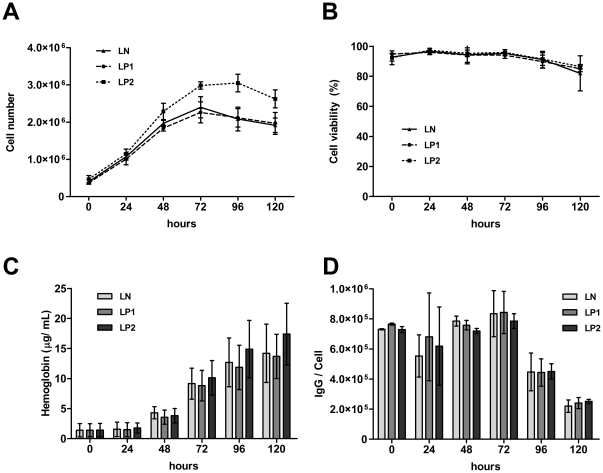
Differentiating MEL cells display similar characteristics irrespective to the level of PrPC expression.(A) Growth curves of LP1, LP2 and control LN lines during erythroid differentiation induced by HMBA. (B) Cell viability based on a Trypan Blue exclusion assay. (C) Concentration of total hemoglobin in the cells per 100 µg/mL of total cell proteins. (D) Number of CD71 (transferrin receptor) molecules per cell, analyzed by quantitative flow cytometry, based on assumption that one anti- CD71-PE mAb binds one molecule of transferrin receptor.